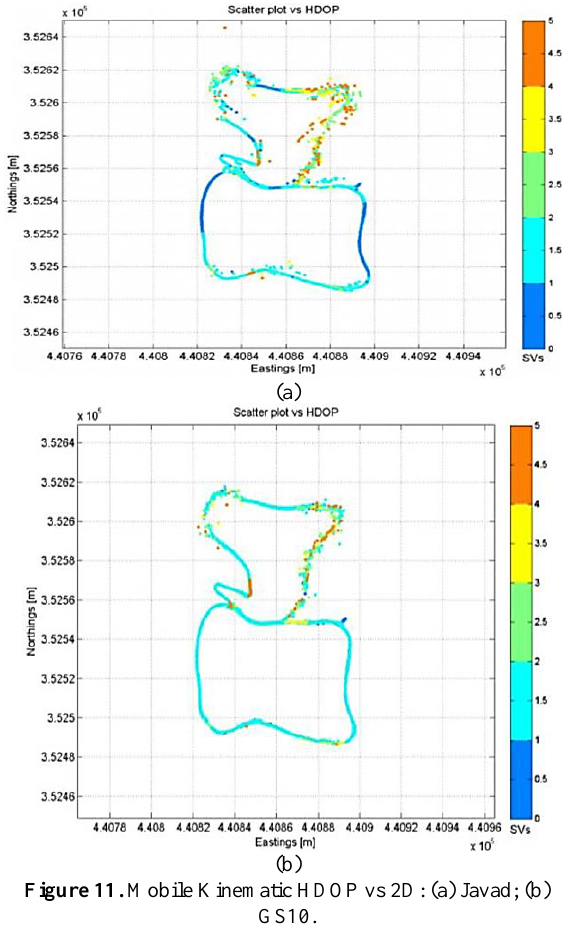
Figure 11. Mobile Kinematic HDOP vs 2D: (a) Javad; (b) GS10.